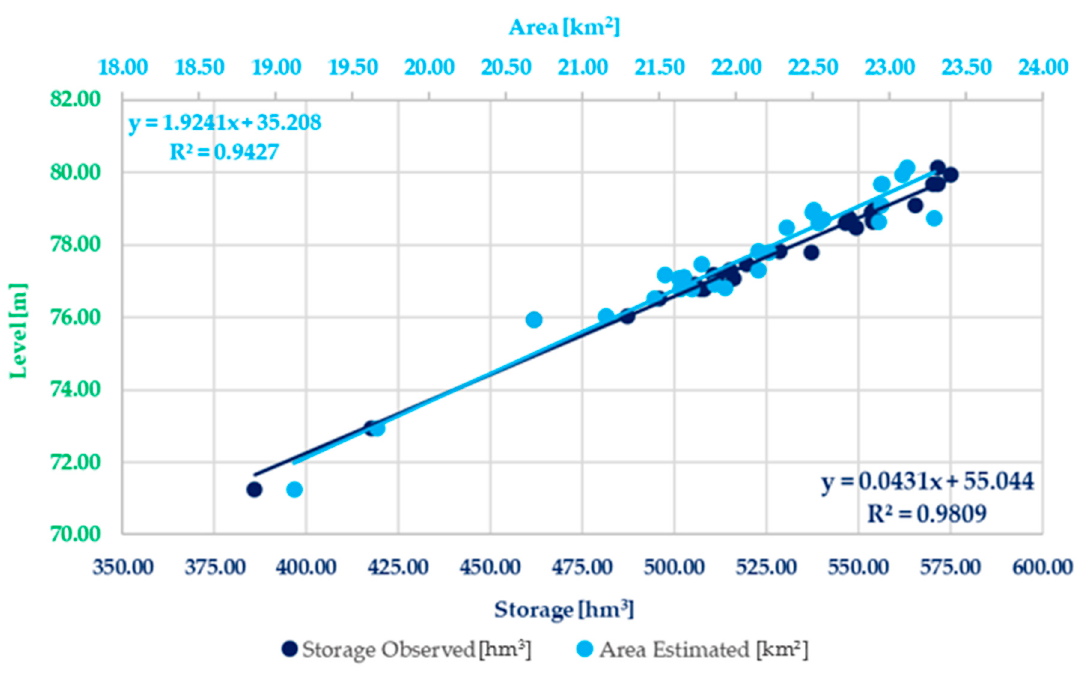
Figure 11. Yliki reservoir water level and area estimated 28 pairs relationship with observed storage.